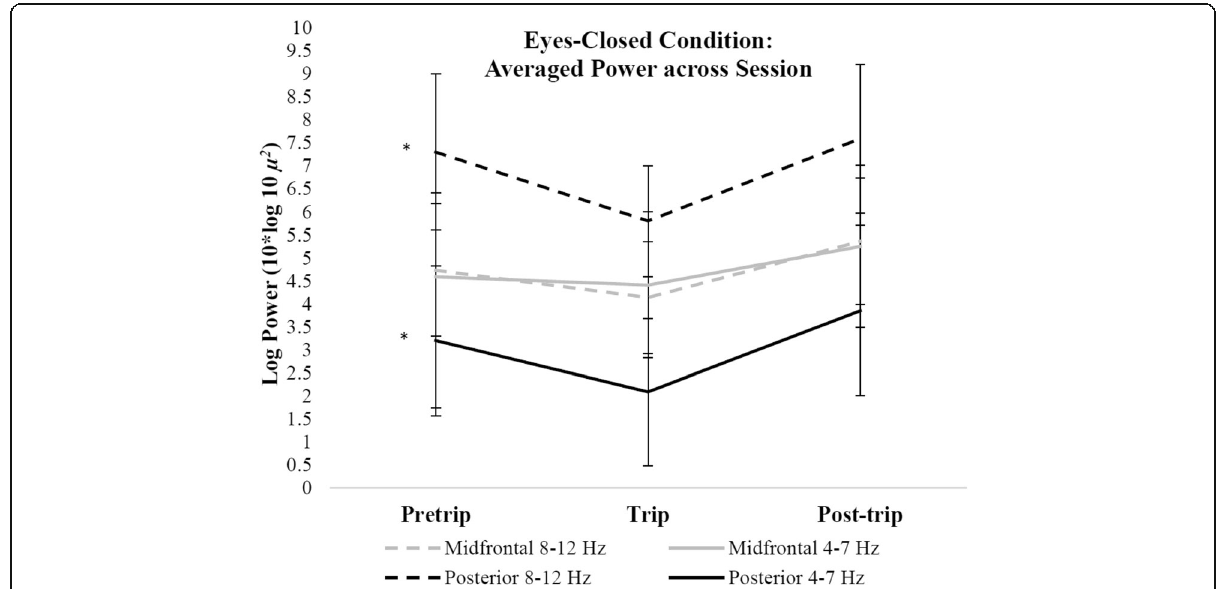
Fig. 4 Changes in log transformed power across sessions during the eyes-closed condition. Error bars indicate 95% confidence intervals around the mean. * p <